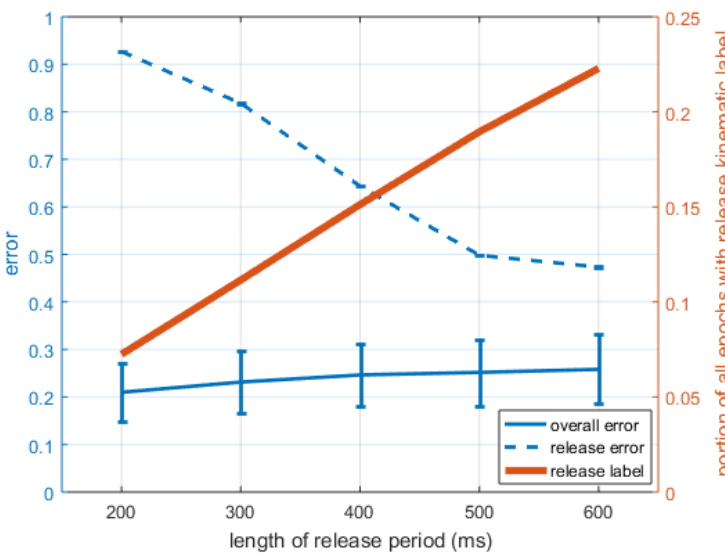
Figure 9. Effect of changing the length for which a kinematic label (hidden state) of “release” was applied for a five-component HMM unigram. Effects on classification error are shown for the overall accuracy of all states and specifically for release. The effect of changing the label length on the portion of all epochs that are labeled as release is also shown. Error bars are the standard deviation of the mean; error bars for release are present, but very